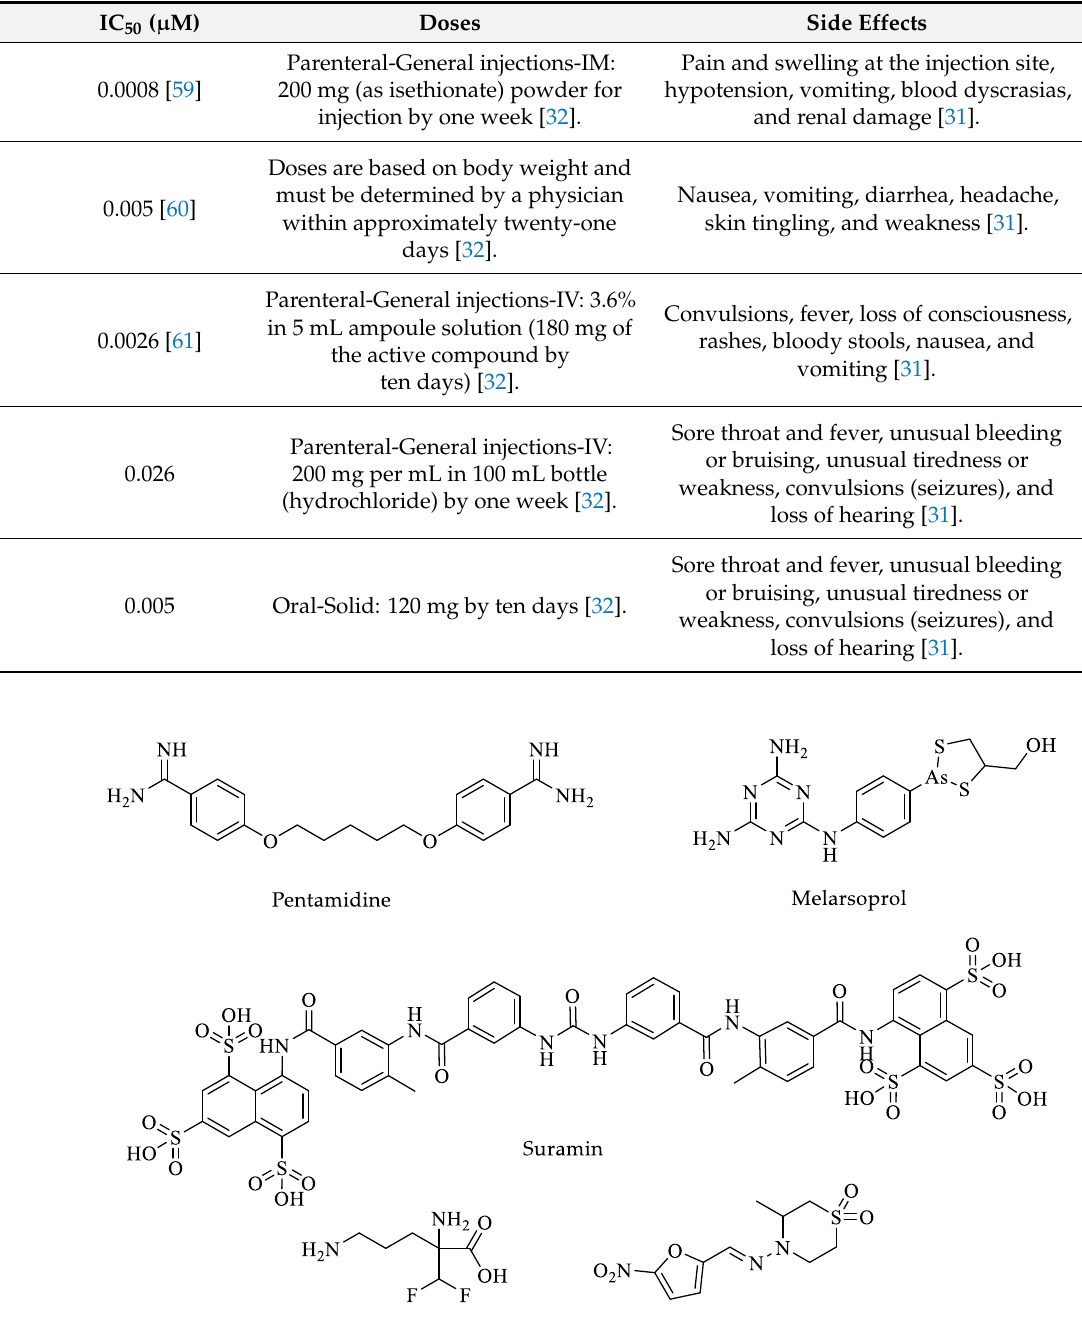
Table 2. Biological activity, dose, and adverse effects of drugs used against T. brucei .